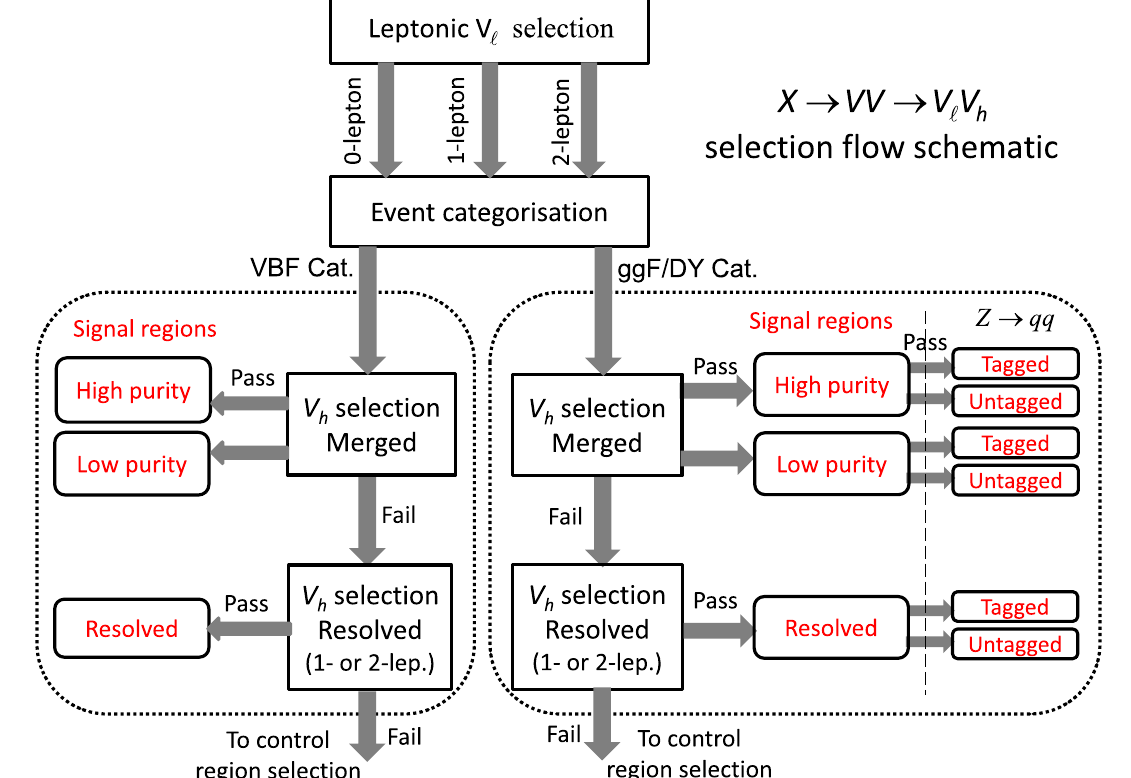
Fig. 2 Illustration of the selection flow and signal regions of the X → V V → V (cid:4) V h search. The VBF category targets VBF production whereas the ggF/DY category is for the rest. Three signal regions (high purity, low purity and resolved) are selected for each category, based on the V → qq reconstruction. For the 0-lepton channel, no resolved